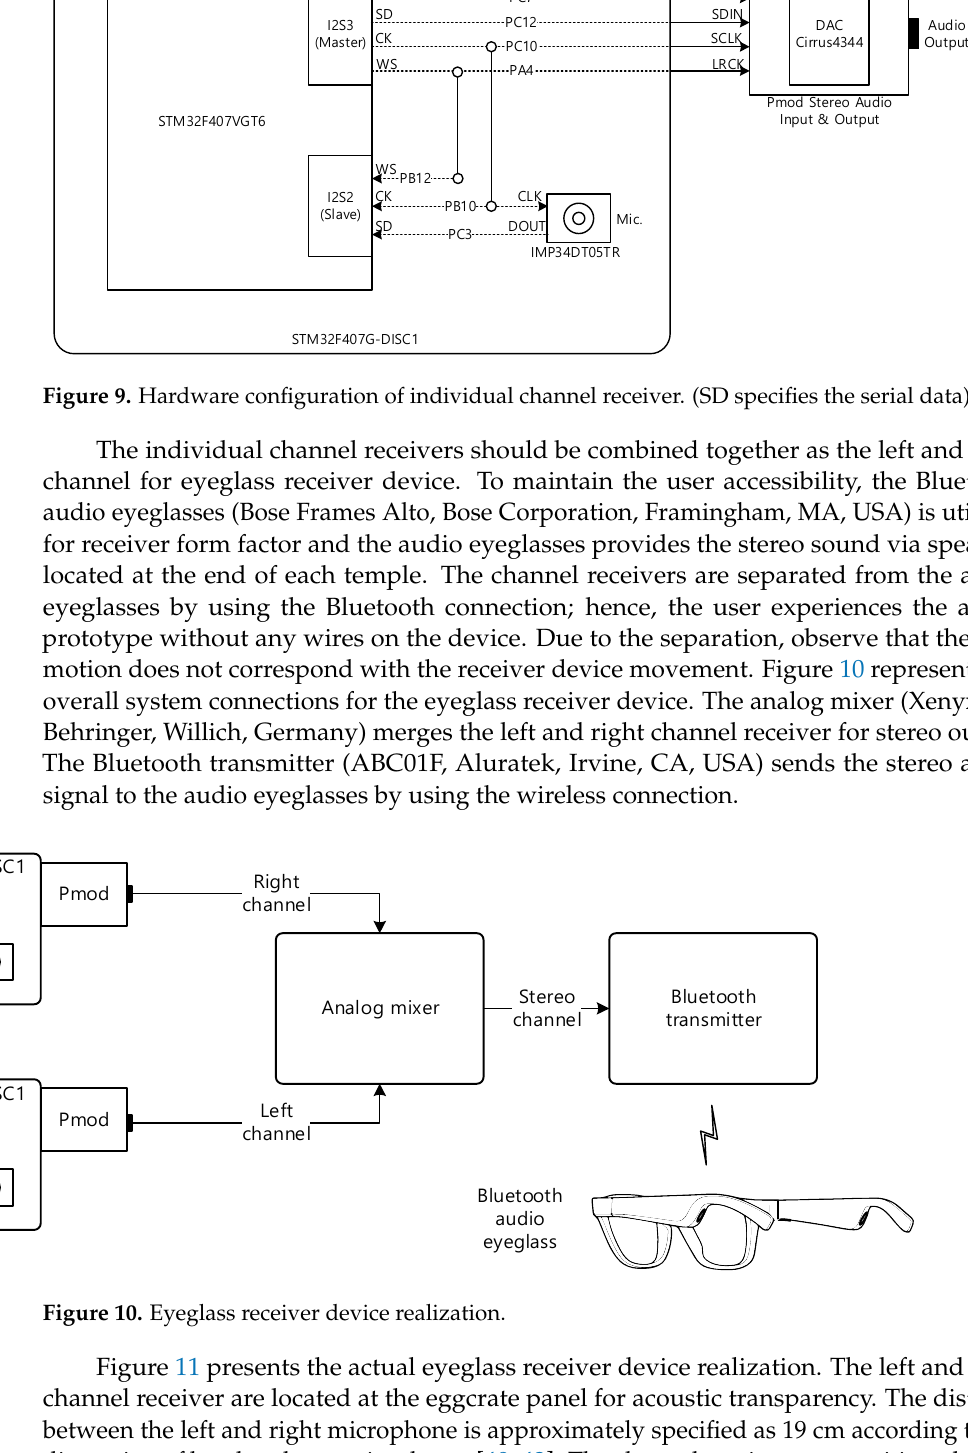
applied for the limited environment to investigate the directional localization. The static